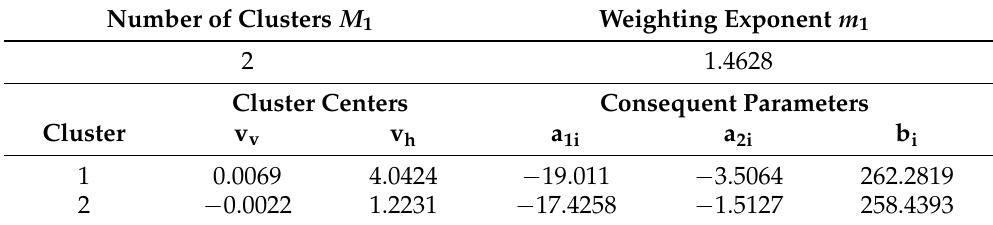
Table 5. Parameters of the first power-estimation subsystem.